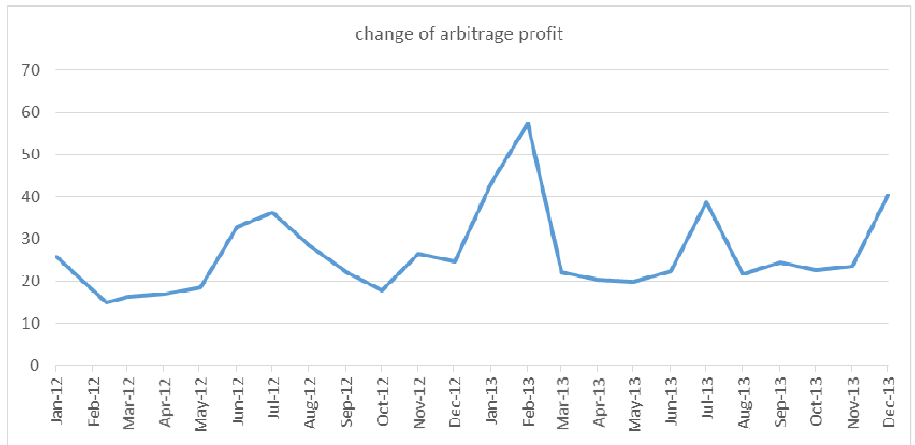
Figure 1. The fluctuation of arbitrage